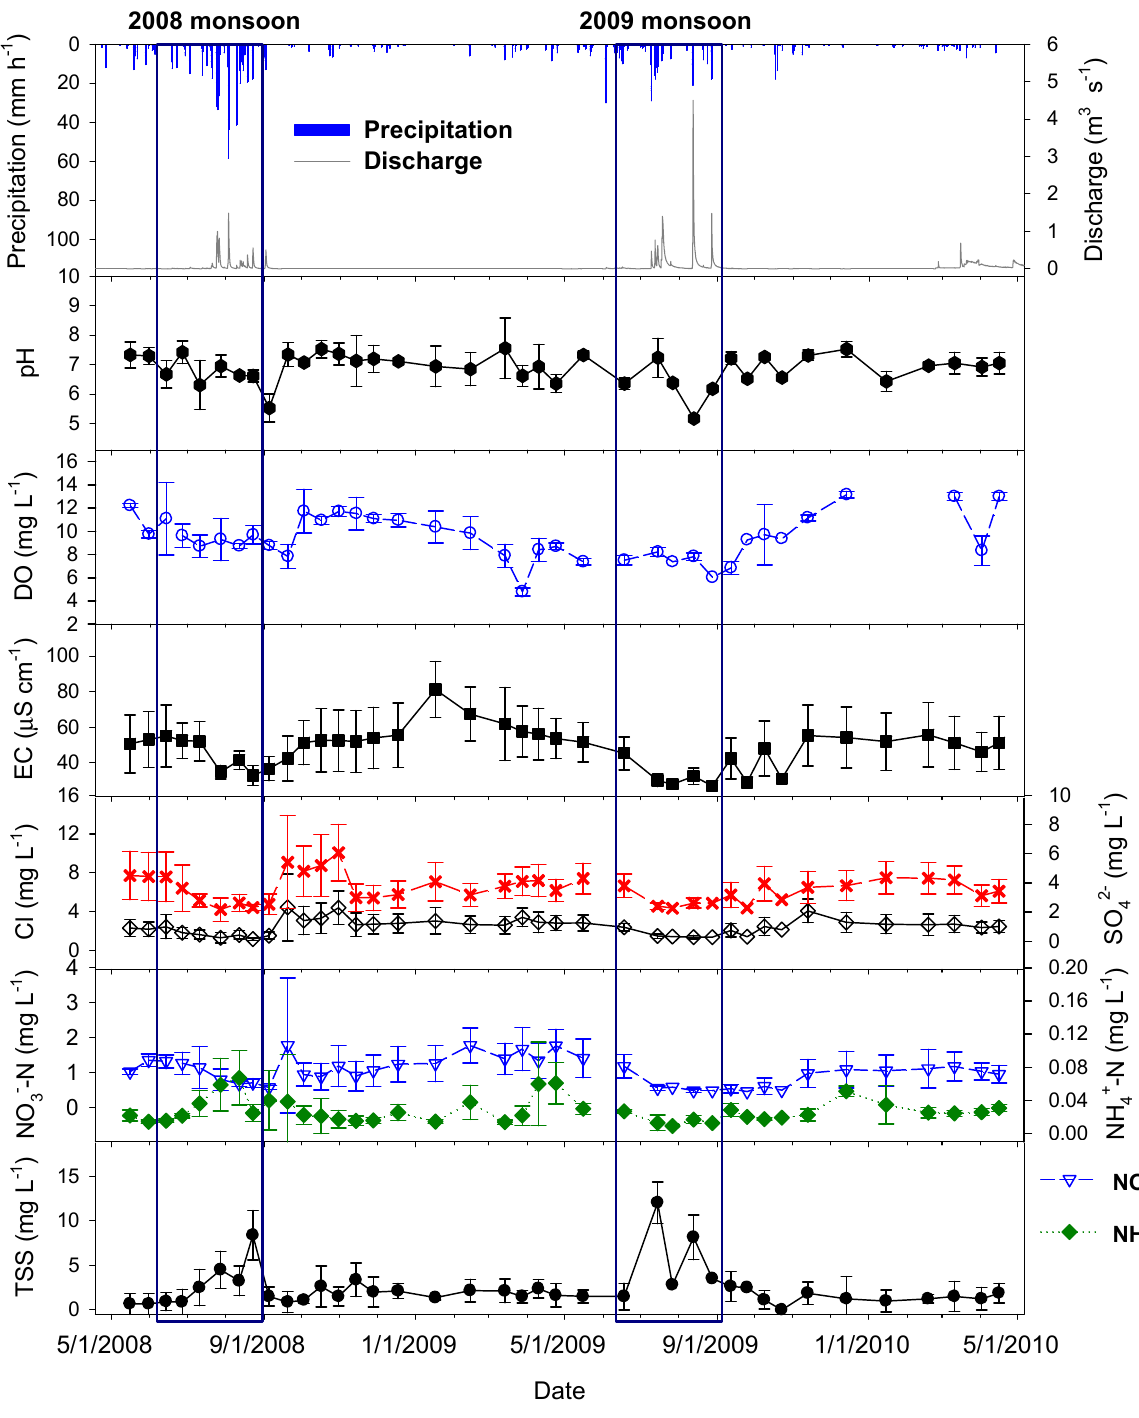
Figure 2. Temporal variations in hourly precipitation (mm), discharge (m 3 ·s − 1 ), pH, EC ( μ S·cm − 1 ), and concentrations (mg·L − 1 ) of DO, Cl − , SO 42 − , NO 3 − –N, NH 4+ –N, and TSS in four forest streams from May 2008 to April 2010. Error bars indicate standard deviations. Data collected during the monsoon period from June through August are indicated by the two rectangular